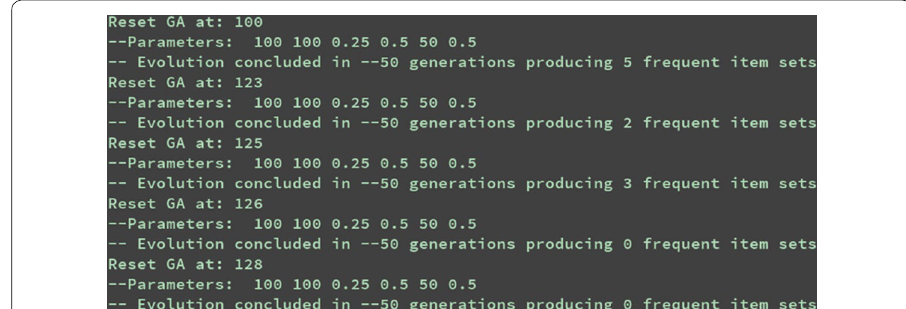
Fig. 10 Small concept drift illustration, illustration 1